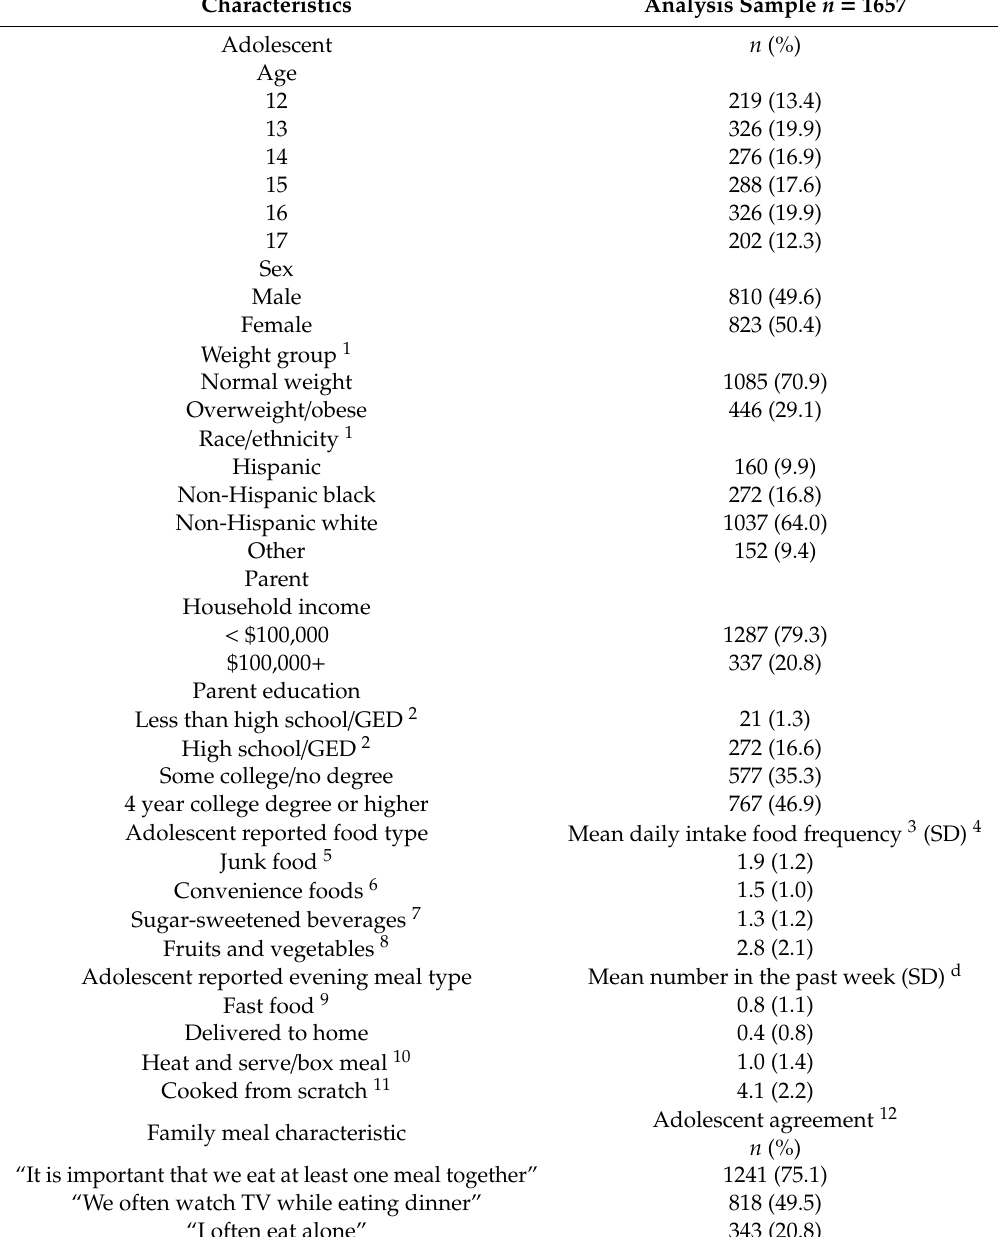
Table 1. Adolescent and parent / household characteristics, adolescent-reported mean daily food frequencies, and mean number of evening meal types in the past